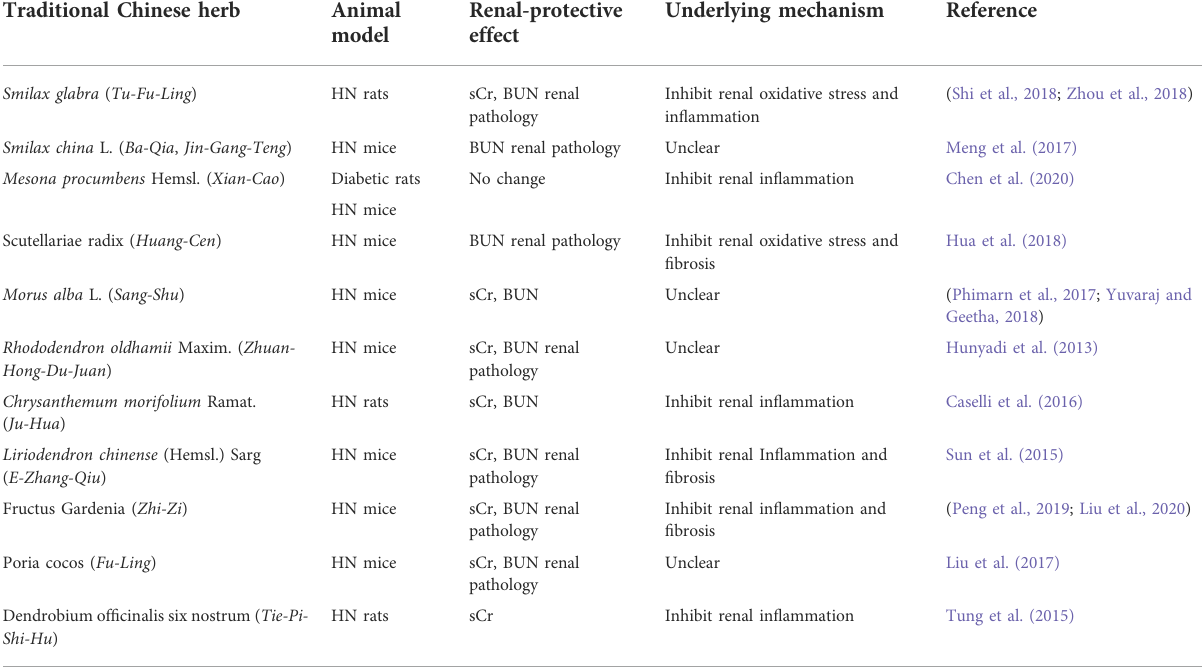
TABLE 2 Renal-protective effects of traditional Chinese